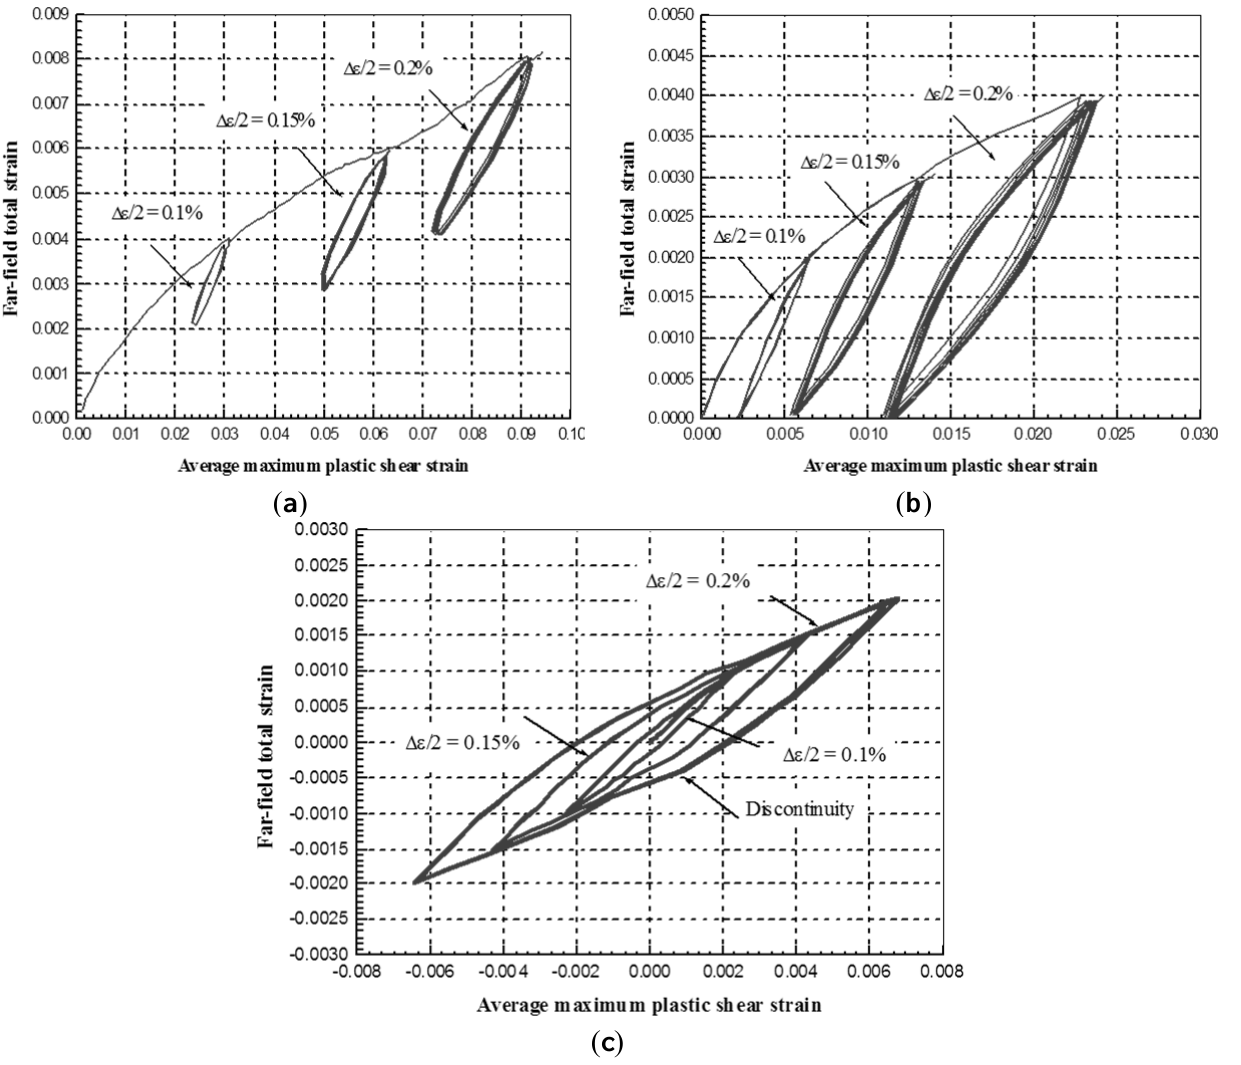
Figure 22. Hysteresis loop for awkward star pore shape under the loading ratio of ( a ) R = 0.5; ( b ) R = 0; and ( c ) R = − 1 [7].